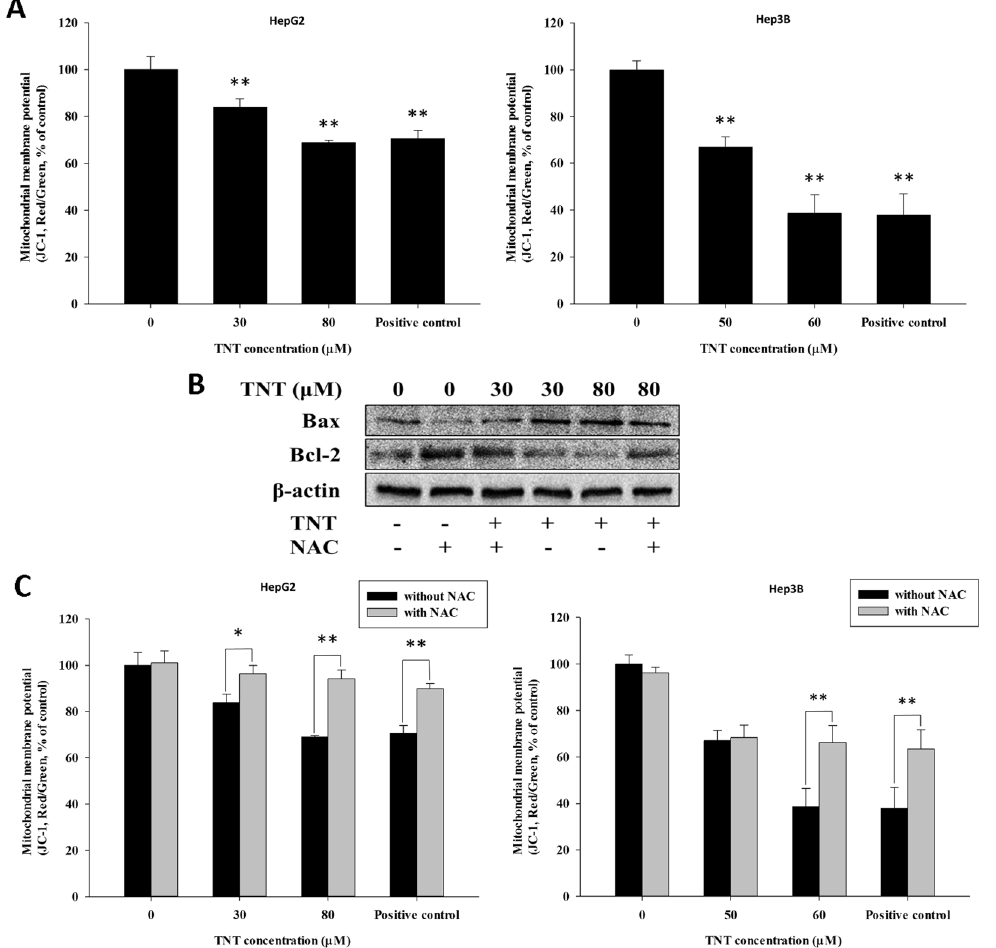
Figure 3. TNT triggered the mitochondrial dysfunction and apoptosis pathways. ( A ) TNT (0, 30, and 80 μ M) caused a disruption of MMP in HepG2 cells, and TNT (0, 50, and 60 μ M) caused a disruption of MMP in Hep3B cells after treatment for 24 h, as evidenced by an increased proportion of cells with green fluorescent light and a decrease proportion of cells with a higher red (JC-1 aggregates)/green (JC-1 monomers) ratio of JC-1 fluorescence. ( B ) TNT-induced mitochondrial dysfunction, as evidenced by Western blot analysis using antibodies against Bax, Bcl-2, and β -actin. ( C ) The cells were treated with different concentrations of TNT for 90 min in the presence or absence of 10 mM NAC, and the dissipation of MMP was measured. (the positive control: 100 μ M H 2 O 2